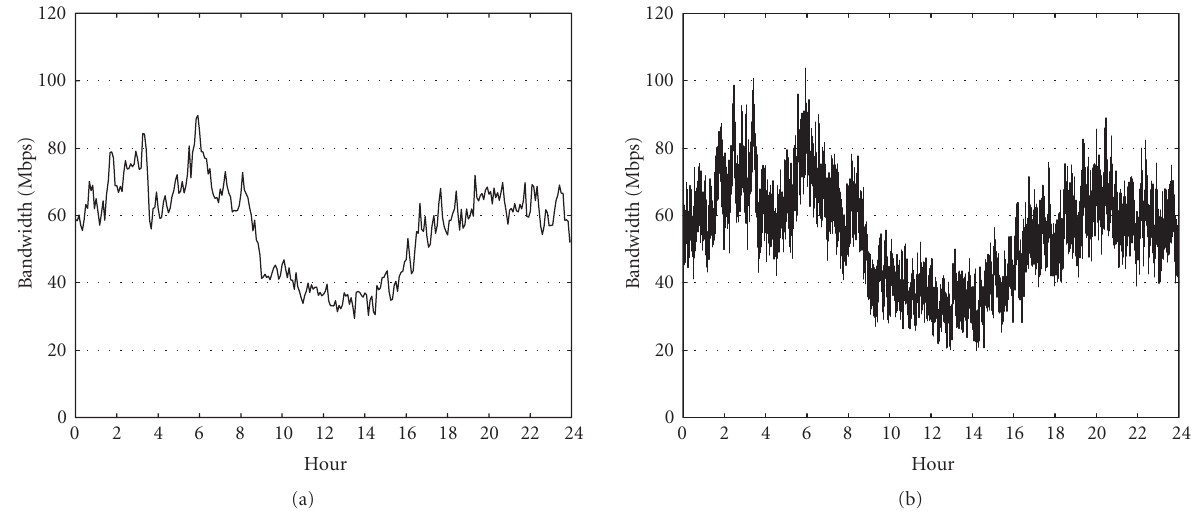
Figure 3: (a) Qbone tra ffi c (5-minute trace), (b) Qbone-shaped tra ffi c aggregate.